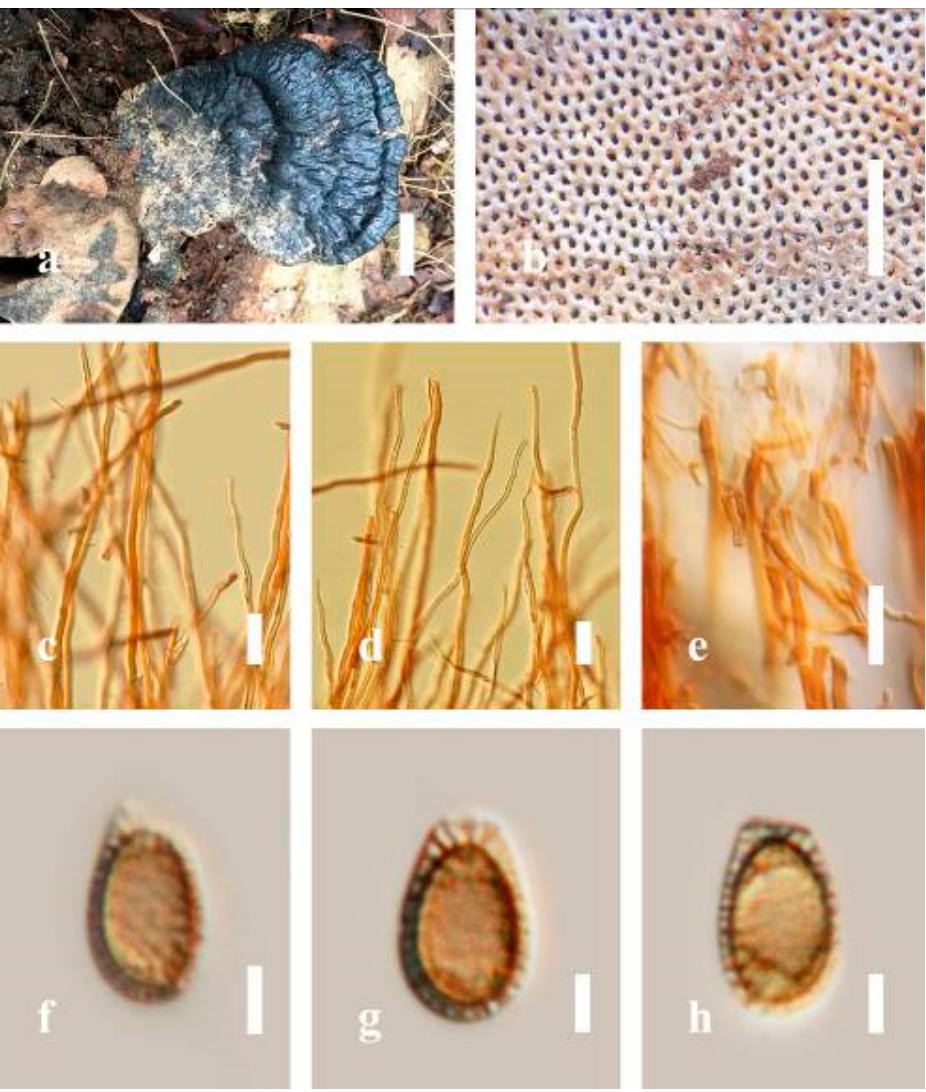
Figure 32. Morphology of Ganoderma subresinosum (MFLU 17 ‐ 1912): ( a ) mature basidiomes; ( b ) pore characteristics; ( c – e ) generative hyphae of context in KOH; ( f – h ) basidiospores in KOH. Scale bars: ( a ) = 2 cm, ( b ) = 1000 μ m, ( c – e ) = 20 μ m, ( f – h ) = 5 μ m. ( a ) = 2 cm, ( b ) = 1000 µ m, ( c – e ) = 20 µ m, ( f – h ) = 5 µ Ganoderma thailandicum T. Luangharn, P.E. Mortimer, S.C. Karunarathna, and J.C.